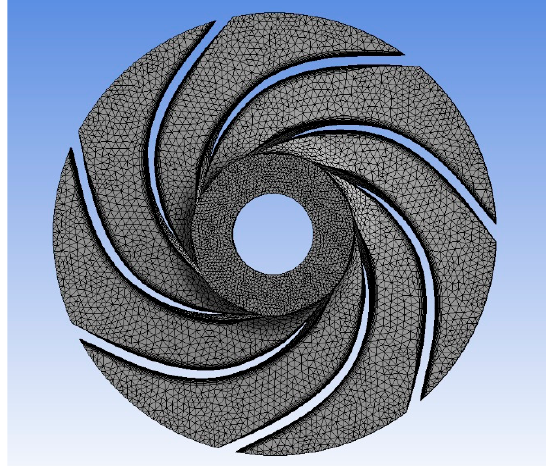
Figure 4. The unstructured meshes of the impeller.